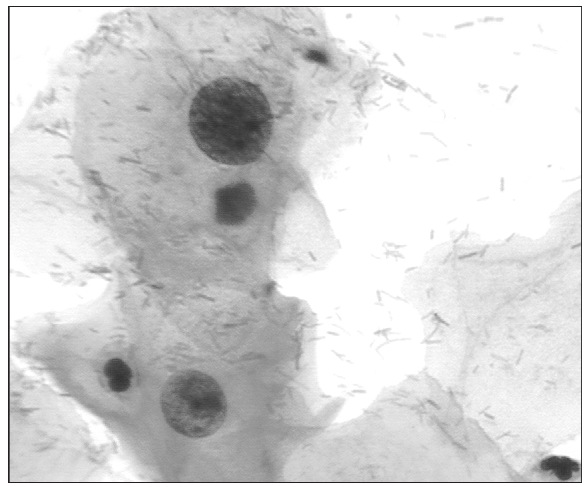
Figura 1 – Ascus: esfregaço